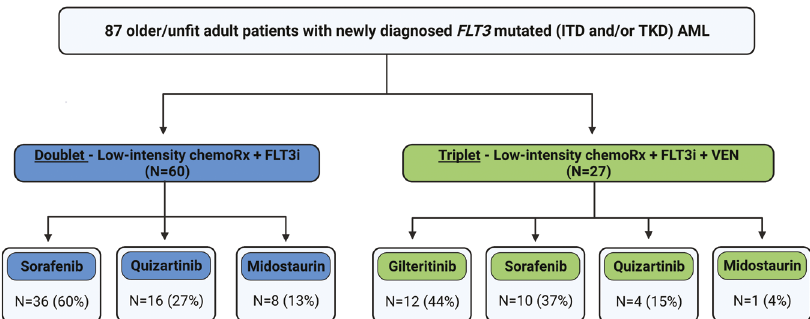
Fig. 1 Flow diagram demonstrating speci fi c FLT3 inhibitor used in the doublet vs. triplet arms. Among the 87 patients enrolled, 60 received doublet therapy and 27 received triplet therapy. In the doublet arm, hypomethylating agents (83%) and cladribine + / − low-dose cytarabine (17%) were used as low-intensity chemotherapy backbones. The most common FLT3 inhibitor in the doublet arm was sorafenib (60%), followed by quizartinib (27%), and midostaurin (13%). In the triplet arm, all patients received a hypomethylating agent (decitabine or azacitidine) as low-intensity chemotherapy backbone. Gilteritinib (44%) and sorafenib (37%) were the most common FLT3 inhibitors used in the triplet arm. ITD internal tandem domain, TKD tyrosine kinase domain; AML acute myeloid leukemia, FLT3i FLT3 inhibitor, VEN